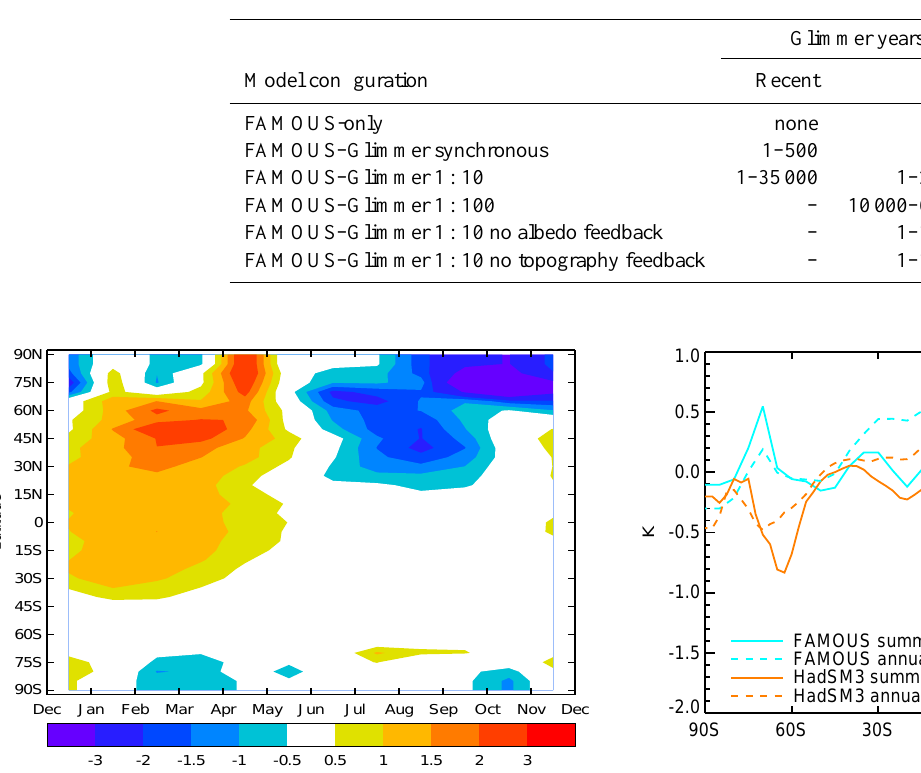
Fig. 1. Difference between 115 ka BP (incipient glacial) and recent conditions (IG minus recent) as a function of latitude and time of year in climatological surface air temperature in years 301–330 of the FAMOUS-only experiments.